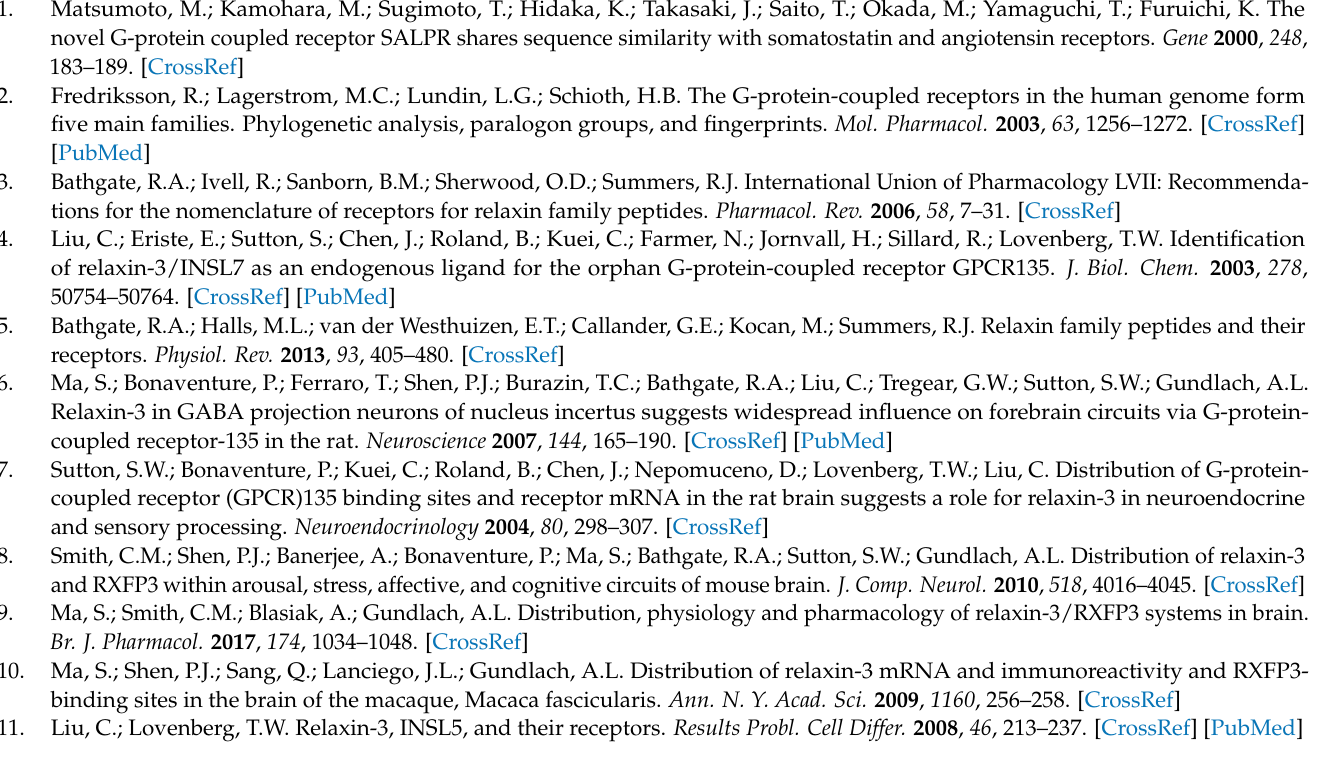
Table S2: Binding of europium-labelled H3 B1-22R to RXFP3 in competition with various small molecules